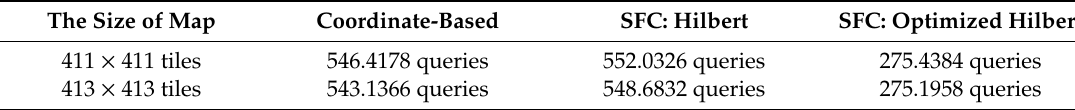
Table 2. Average number of queries of three methods with di ff erent map sizes. The Size of